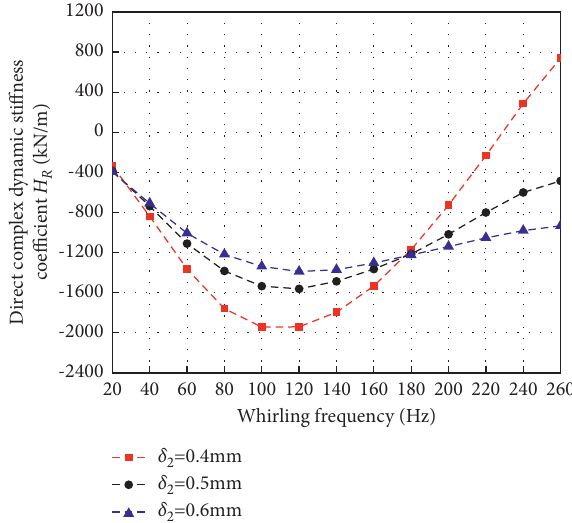
Figure 22: Average direct damping coefficient vs. whirling frequency.